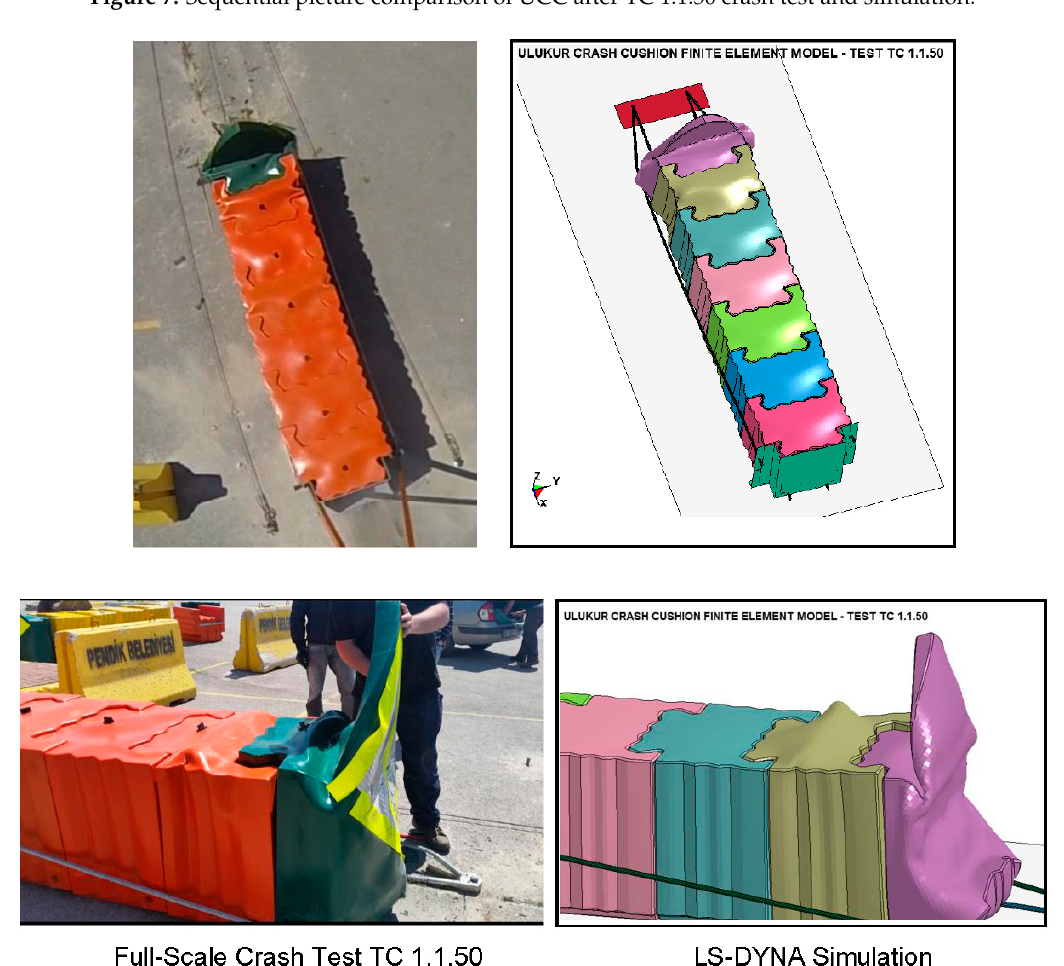
Figure 8. Deformed shape comparison of UCC after TC 1.1.50 crash test and simulation.